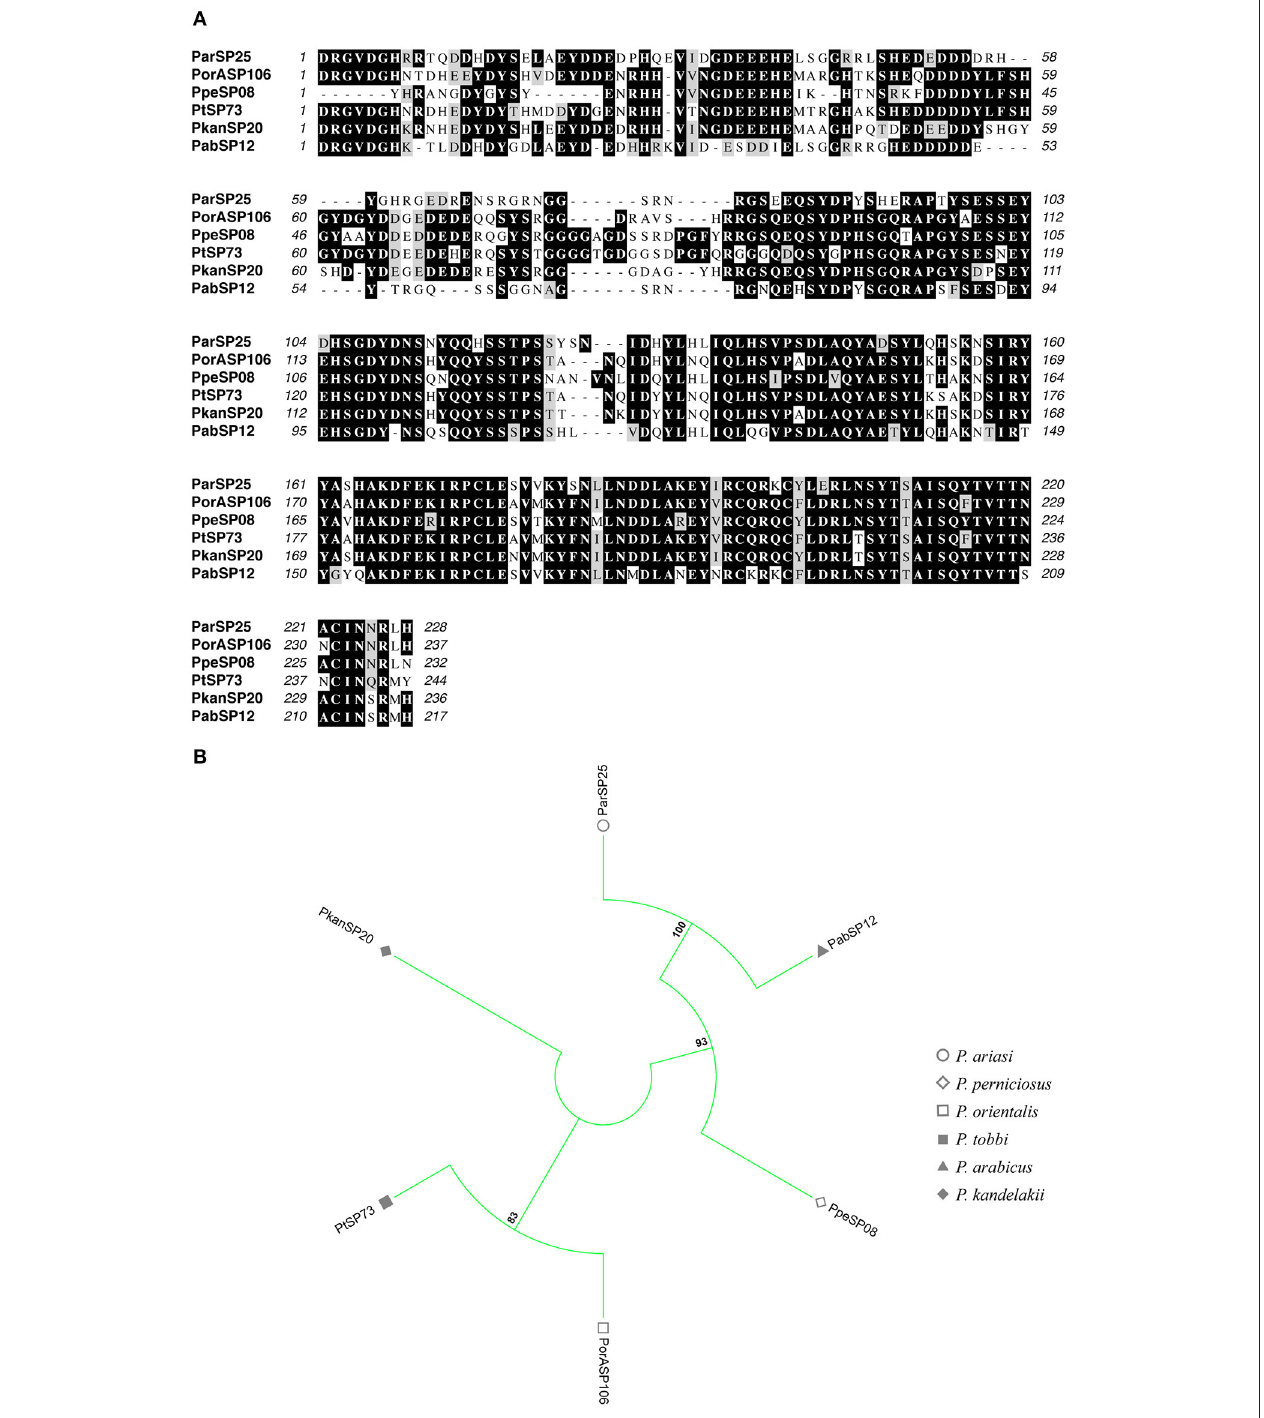
FIGURE 8 | Multiple sequence alignment and molecular phylogenetic analysis of the sand fly ParSP25 salivary protein family. (A) Multiple sequence alignment of ParSP25 proteins . ParSP25 ( P. ariasi ), PorASP106 ( P. orientalis ), PpeSP08 ( P. perniciosus ), PtSP73 ( P. tobbi ), PkanSP20 ( P. kandelakki ), and PabSP12 ( P. arabicus ). Black background shading represents identical amino acids. Gray background shading represents similar amino acids. (B) The evolutionary history of ParSP25 salivary protein family was inferred by using the Maximum Likelihood method based on the JTT matrix-based model (Jones et al., 1992). Sand fly species are indicated by the different symbols in the legend on the